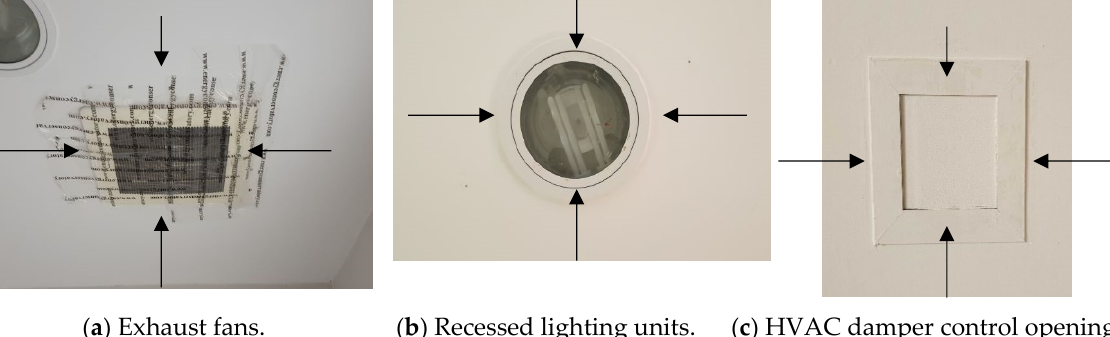
Figure 8. Possible air leakage paths in the ceiling. (shown by arrows). Furthermore, the outdoor air inlet terminals in the return ducts near the package units were sealed during the airtightness test scenarios to eliminate any air leakage through them, as illustrated in Figure 9. Notably, in House B, the dampers in both outdoor inlet terminals were closed.